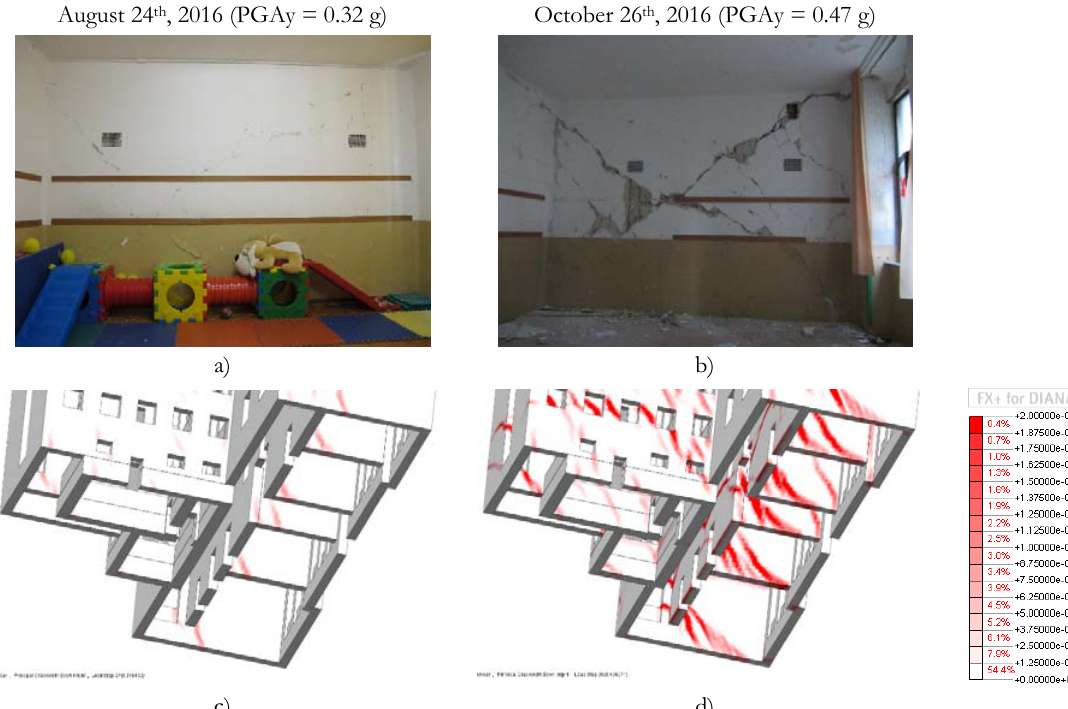
Figure 22: Correlation between the real and numerical damage occurred in the internal walls of body A due to the August 24 th (left) and October 26 th (right) earthquakes: a-b) cracks observed in-situ [11, 12], c) crack pattern in terms of principal crack width for a horizontal load of 0.32 g in the -Y direction, d) crack pattern in terms of principal crack width for a horizontal load of 0.44 g in the -Y